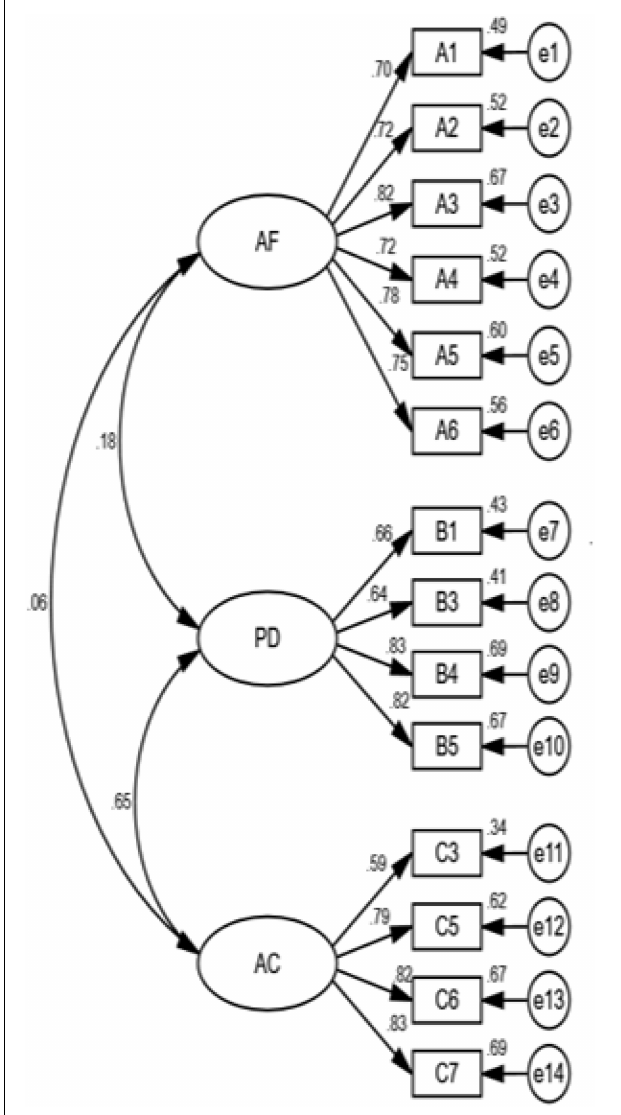
FIGURE 2 | The 2-dimensional confirmatory factor